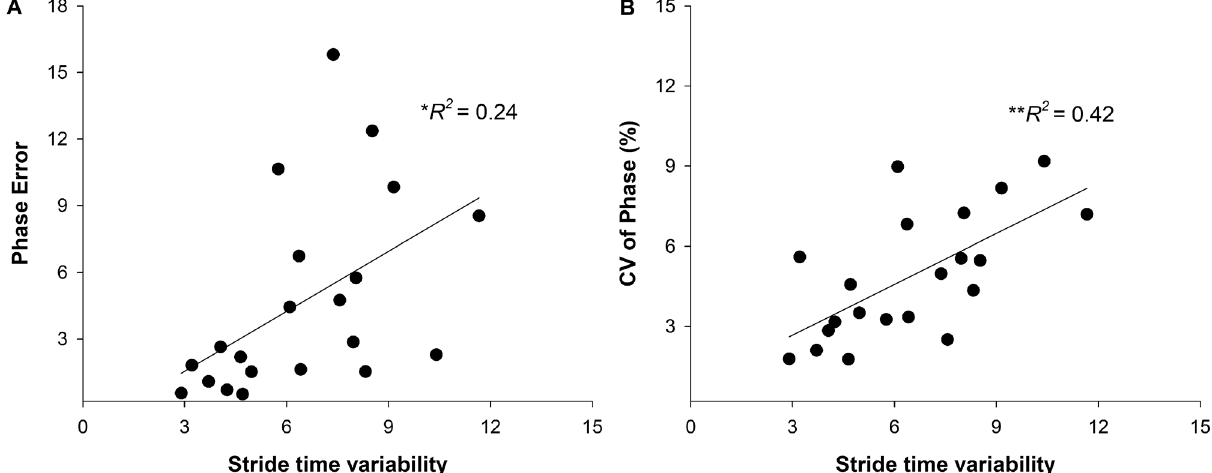
Figure 4. Predicting phase accuracy and consistency of phase from gait variability measures. Multiple regression analysis in the stroke group showed that stride length variability significantly predicted both ( A ) phase error and ( B ) CV of phase. Stride length variability did not emerge as a significant predictor of phase error and CV of phase in any of the regression analyses. * p < 0.05; ** p <